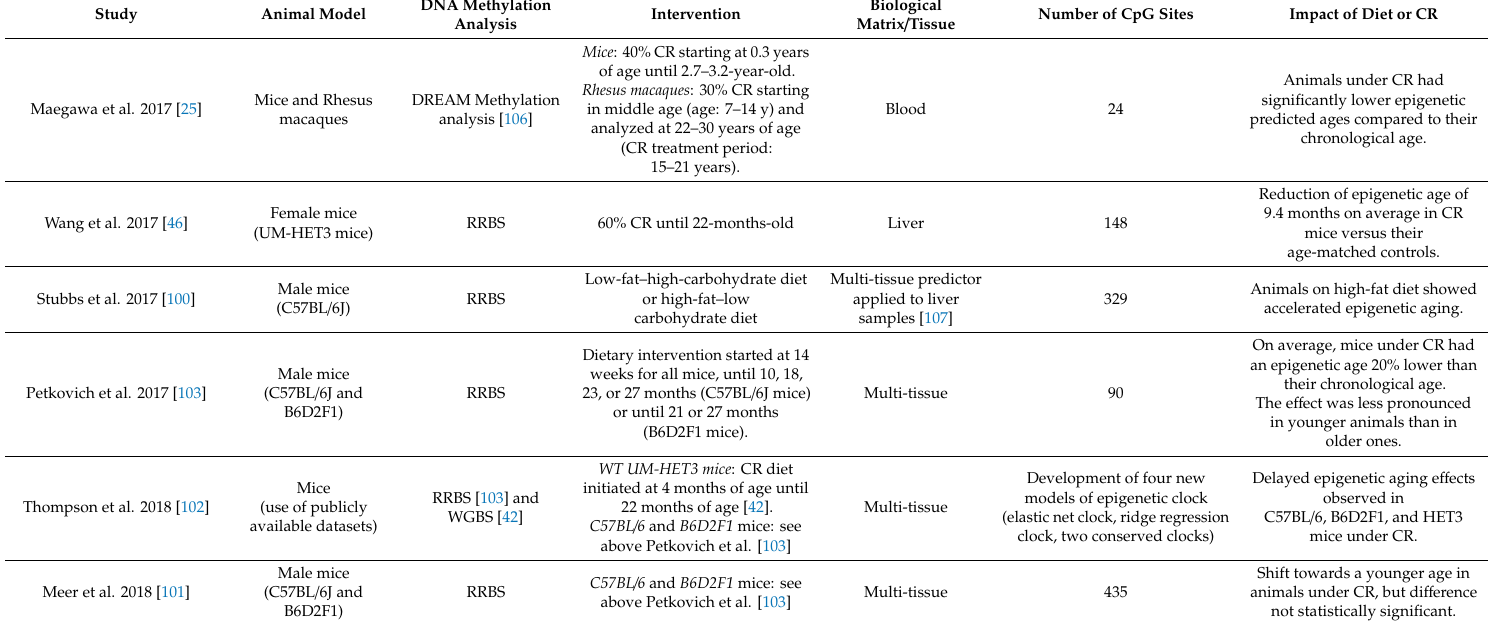
Table 2. Epigenetic clocks in animal